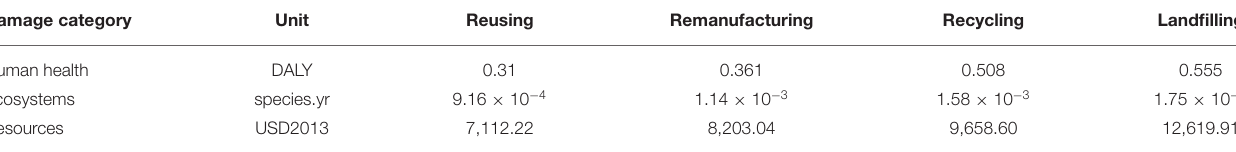
TABLE 3 | Impact of reverse logistics strategies on end-point